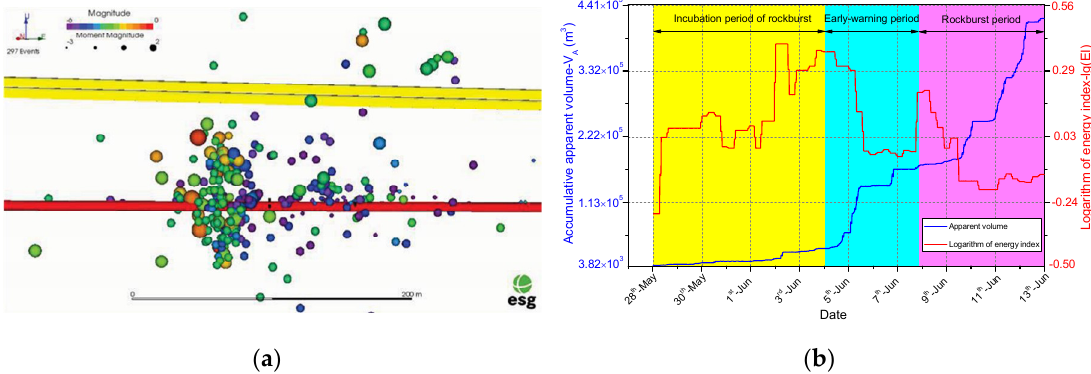
Figure 8. Significant characteristics of rockburst: ( a ) MS events before an extreme rockburst; ( b ) The apparent volume and energy index.